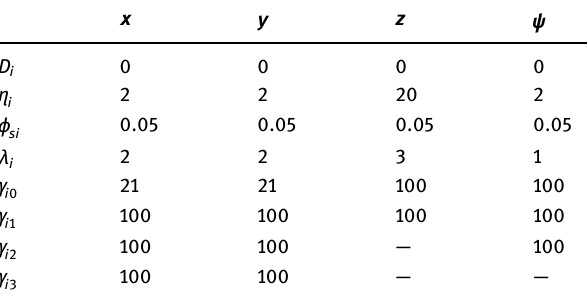
Table 1: Controller gains for all four control subsystems for NASMC